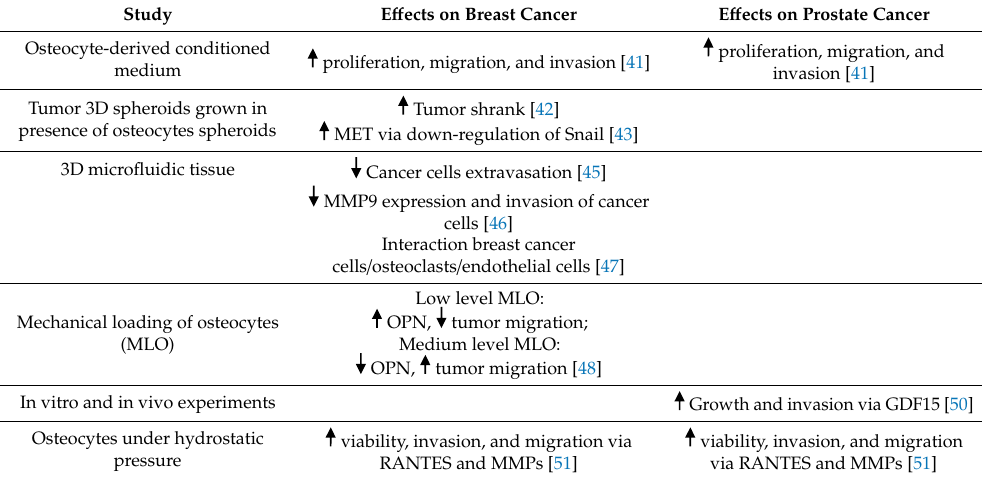
Table 1. Overview of studies on the influence of osteocytes on breast and prostate cancer cells.